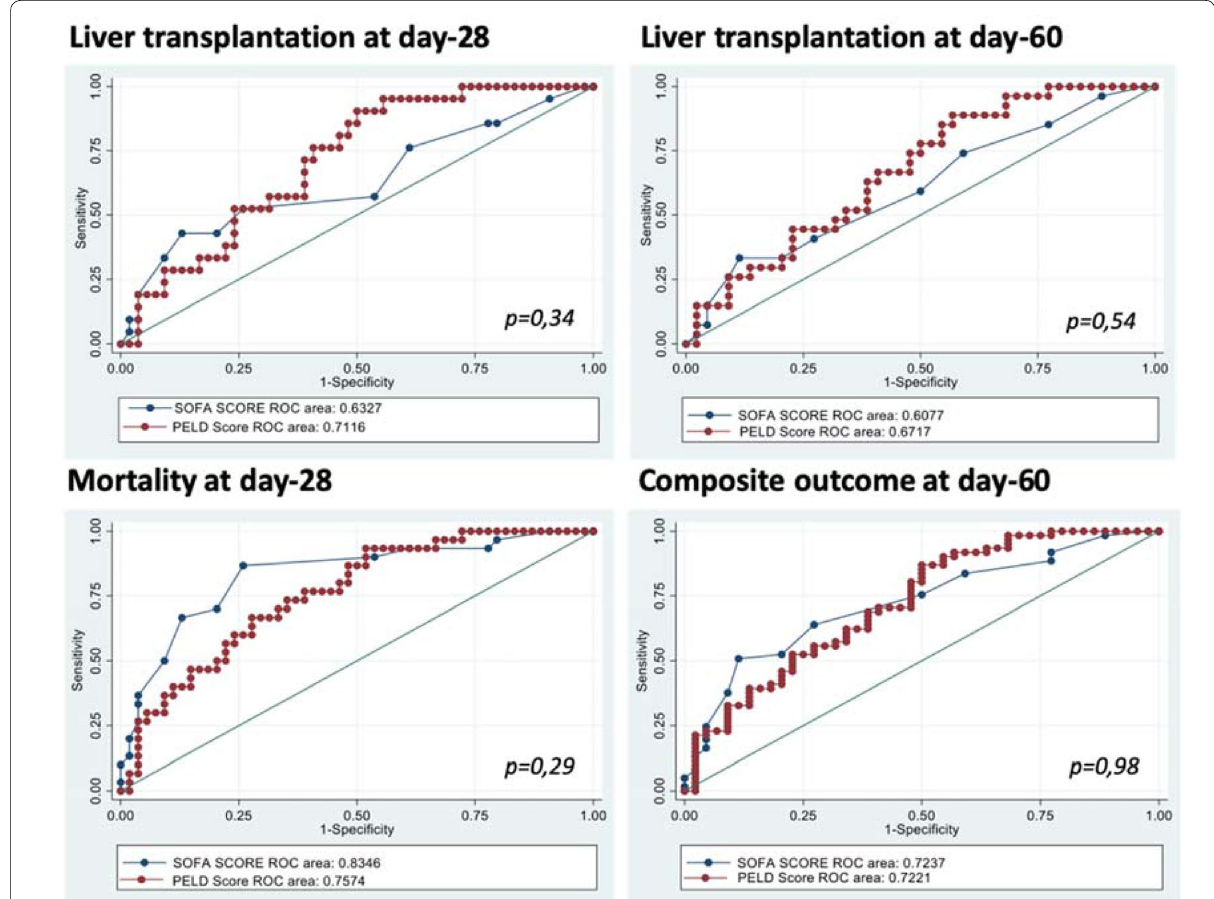
Fig. 2 Receiver operating characteristics curves showing the discrimination ability of the pCLIF‑SOFA and PELD scores in predicting liver